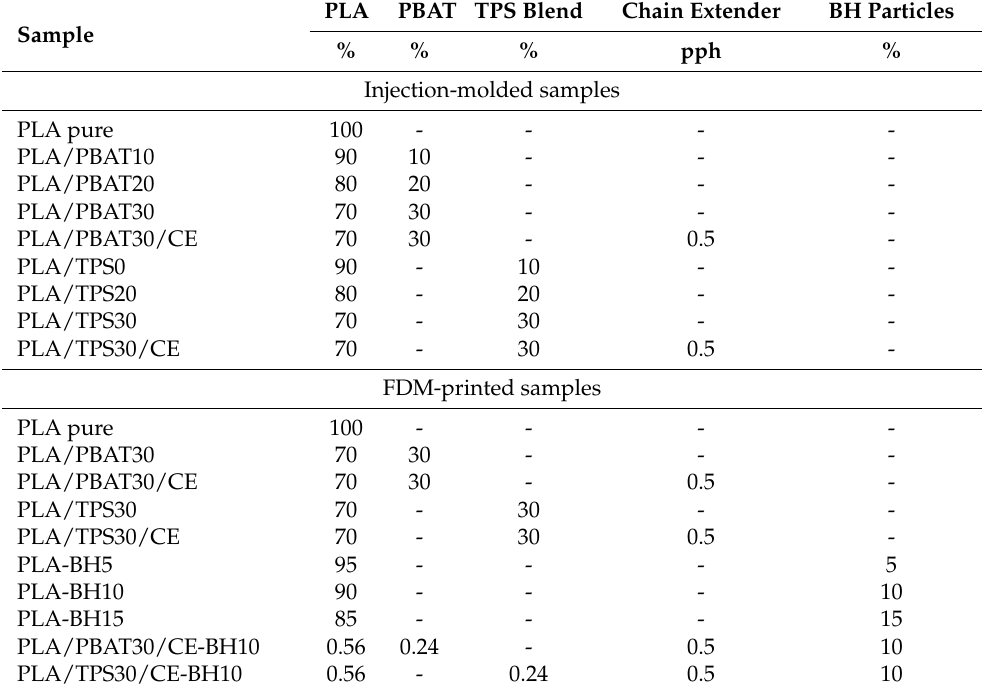
Table 1. The list of samples prepared by injection molding and FDM